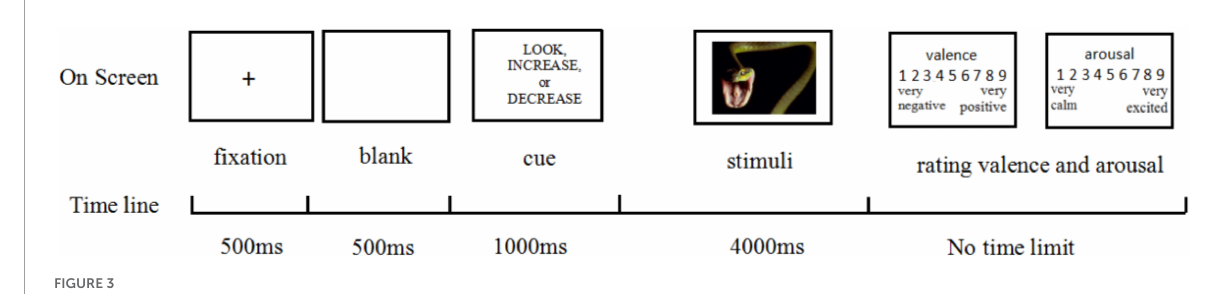
FIGURE3 Sample trial sequence of the emotion regulation task.